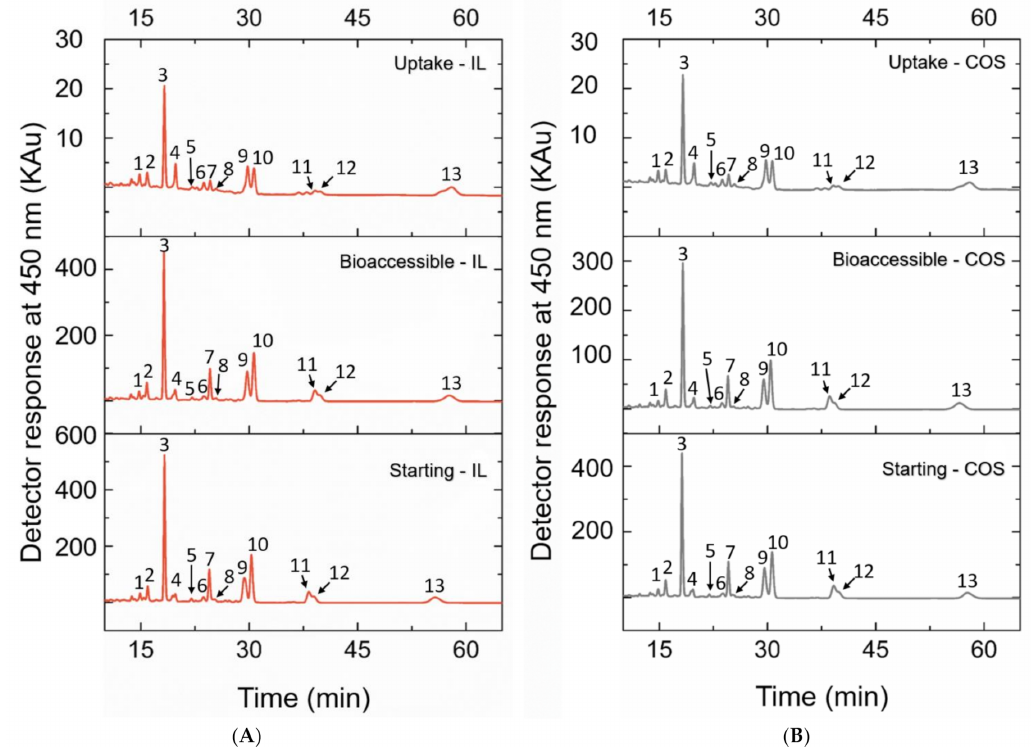
Figure 2. Chromatograms obtained by HPLC-PDA of carotenoid extracts from peach palm fruits via ( A ) IL xtraction; ( B ) COS extraction. For both extracts, the chromatograms are of the starting (before in vitro digestion), bioaccessible phase, and uptake samples. Peak 1: 13- cis - β -carotene; Peak2: all- trans - α -carotene; Peak 3: all- trans - β -carotene; Peak 4: cis - δ -carotene (1); Peak 5: cis - δ -carotene (2); Peak 6: cis - δ -carotene (3); Peak 7: all- trans - δ -carotene; Peak 8: cis - γ -carotene (1); Peak 9: all- trans - γ -carotene; Peak 10: cis - γ -carotene (2); Peak 11: cis - γ -carotene (3); Peak 12: 9- cis -lycopene; Peak 13: all- trans